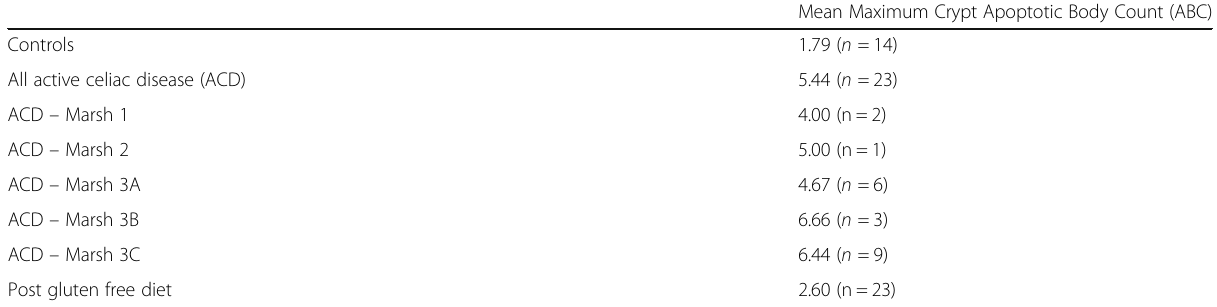
Table 1 Mean maximum crypt ABC when comparing active celiac disease biopsies with post gluten-free diet biopsies